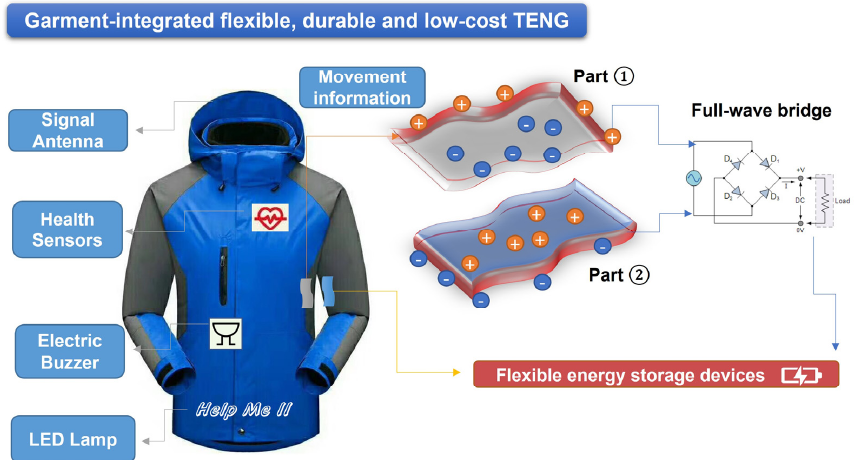
Figure 9. The potential applications of the flexible and robust G-TENG. To facilitate storage, a recti- fier bridge can be added to the system to convert alternating current into direct current, and a flex- ible energy storage device can be used to collect the electrical energy harvested from everyday ac-